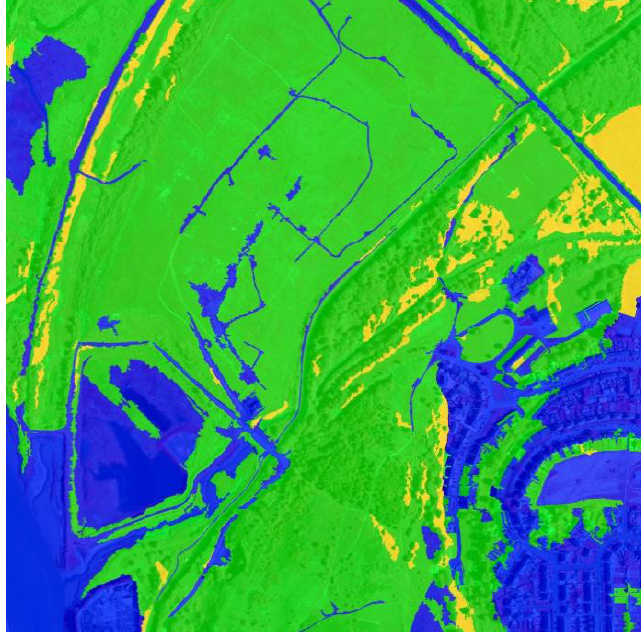
Figure 5. Output (30% transparent) of 2nd multiresolution segmentation process (Level 2), showing ‗Candidate Knotweed Class‘